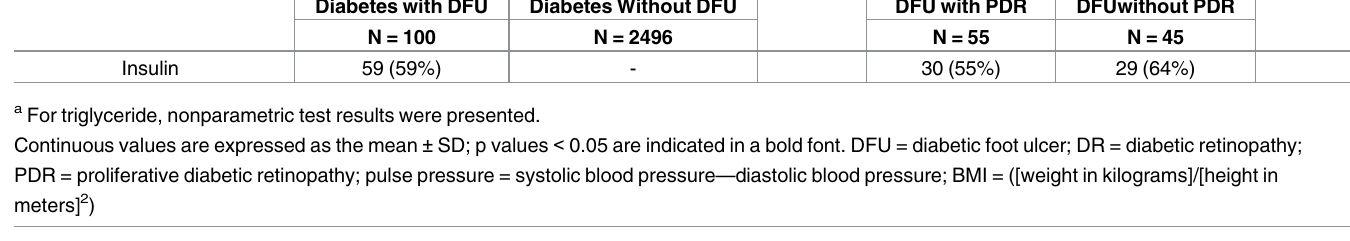
Patients with DFU were compared with the control (diabetes) group (N = 2496) in terms of each clinical variable. The DFU group was older in age, and demonstrated higher pulse pres- sure (systolic BP—diastolic BP), lower BMI, lower cholesterol and hematocrit levels, and higher HbA1c and serum creatinine levels than the control group, as shown in Table 1. Addi- tionally, patients with DFUs were divided into two groups according to DR severity, and demographic, clinical, and biochemical characteristics were compared between the two groups. The PDR group had a longer duration of diabetic mellitus (20.6 vs. 15.8 years), and higher BUN (32.8 vs. 23.7 mg/dL) and serum creatinine (4.1 vs. 1.7 mg/dL) levels than the NPDR group.